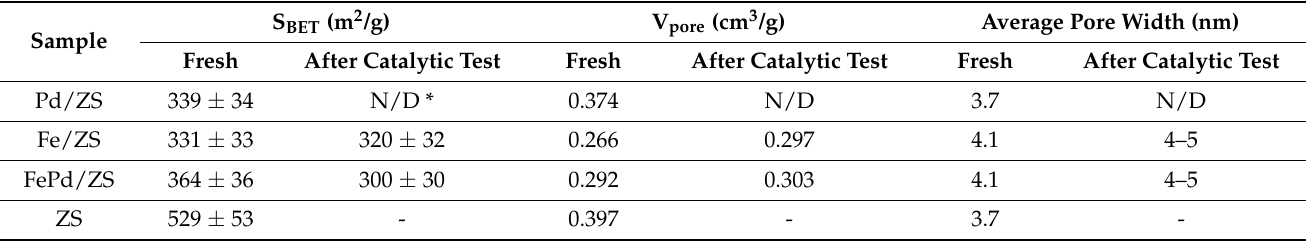
Table 1. Morphological properties of unreduced catalysts (fresh) and the same systems after catalytic tests.